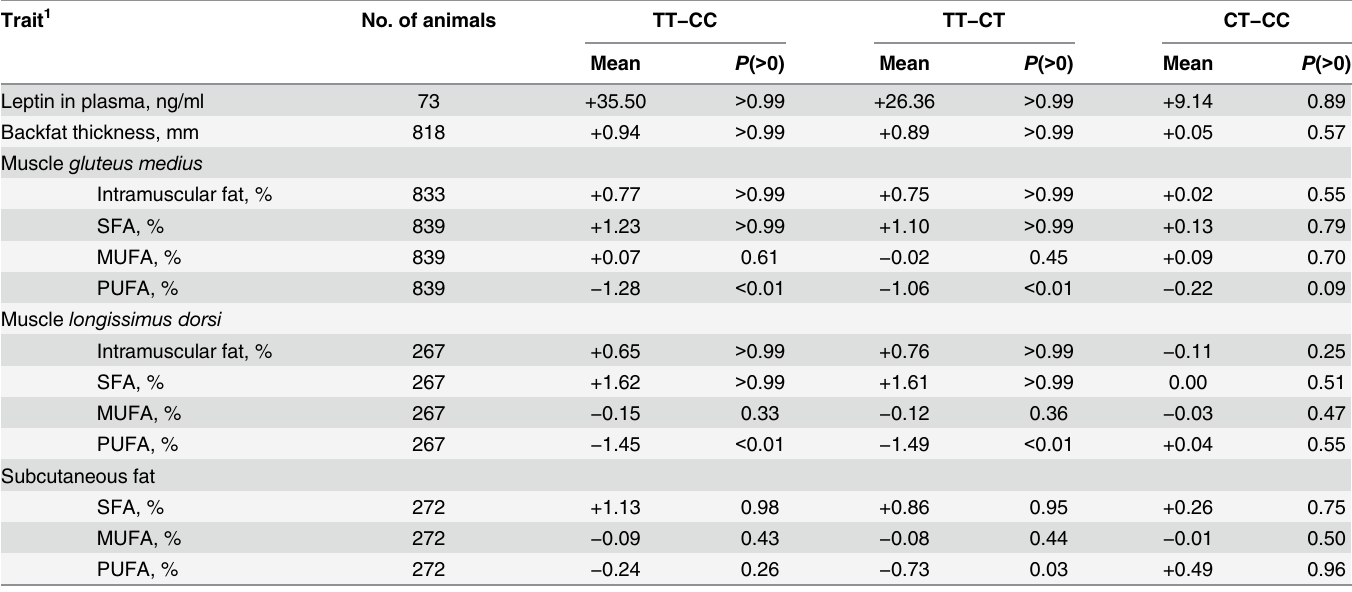
Table 3. Mean of the estimated marginal posterior distribution of differences between NM_001024587: c . 1987C > T genotypes and probability of the difference being greater than zero ( P ( > 0)) for leptin concentration in plasma and fat-related traits in the independent set. Trait 1 No. of animals